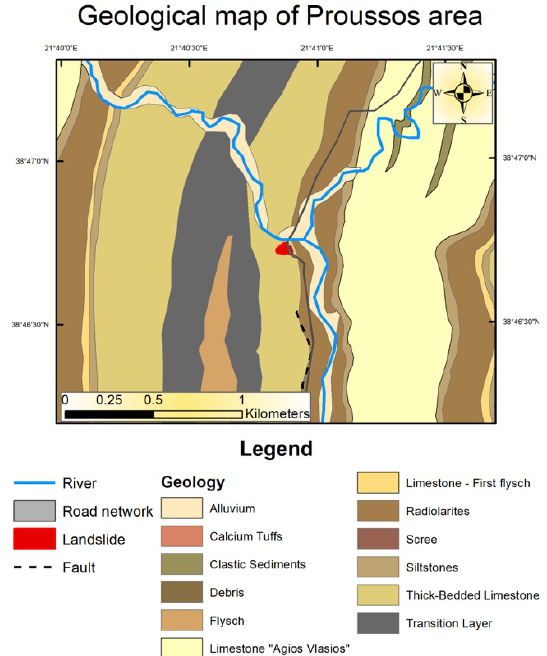
Figure 2. Geological map of Proussos area (Digitized from